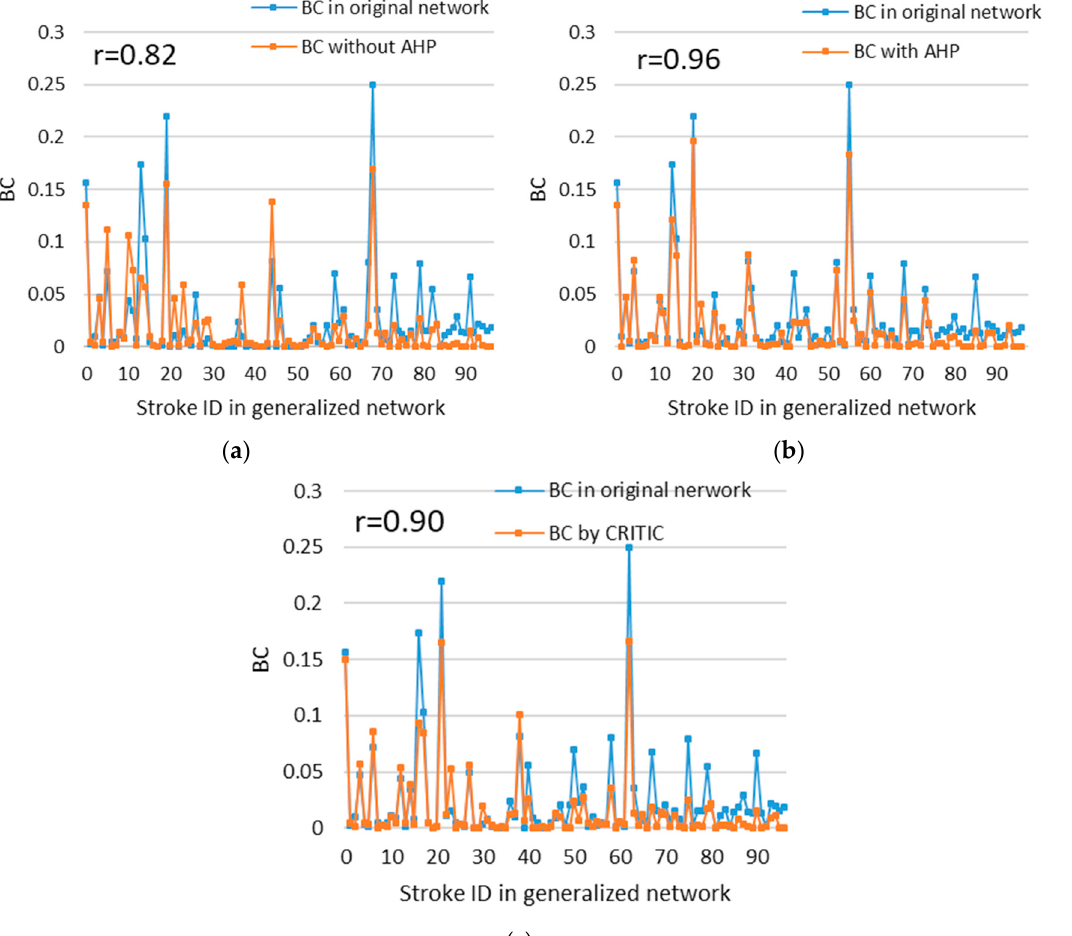
Figure 8. The statistics of the BC values of the selected roads before and after the three selection processes: ( a ) The BC values of the selected roads without AHP; ( b ) the BC values of the selected roads with AHP; ( c ) the BC values of the selected roads using the CRITIC. The Pearson correlation coe ffi cient r reveals the similarity of the topological characteristics between the generalized results and the original road network.